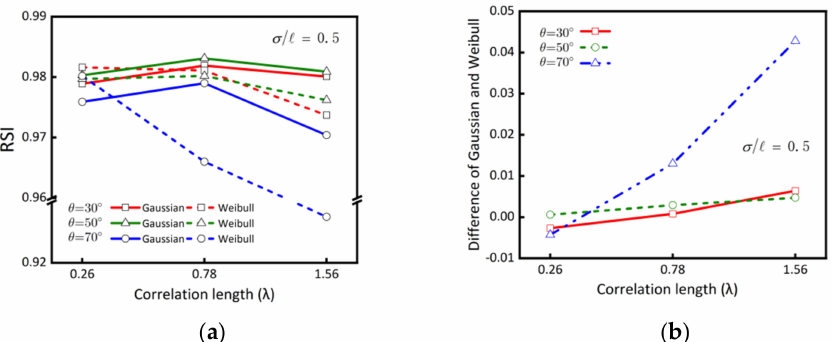
Figure 12. Rough surface index (RSI) for three roughness scales of 0.13 λ /0.26 λ , 0.39 λ /0.78 λ , 0.78 λ /1.26 λ . ( a ) RSI, ( b ) Difference of